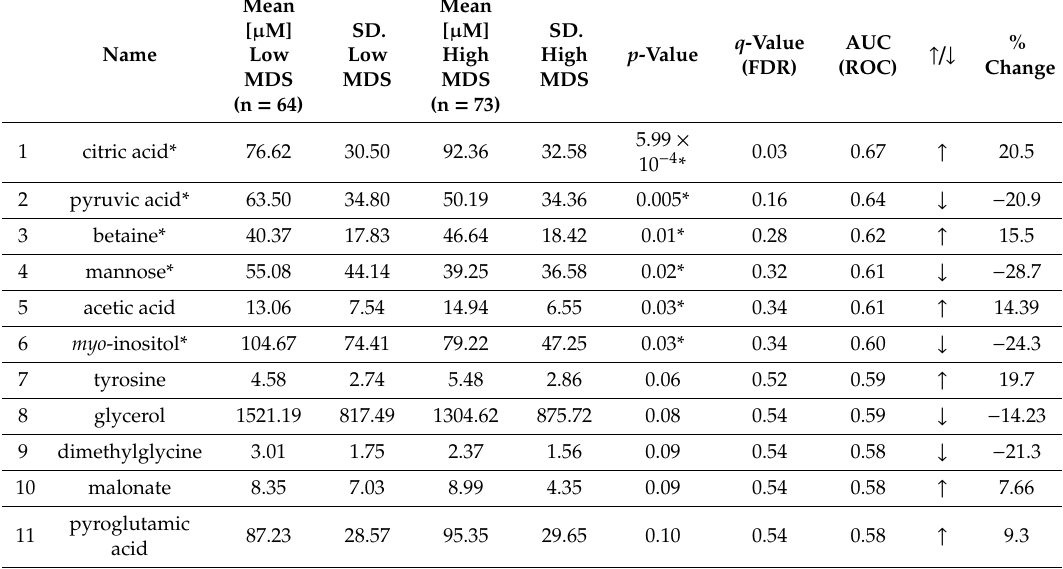
Table 1. Metabolite levels di ff ering according to low or high Mediterranean diet score